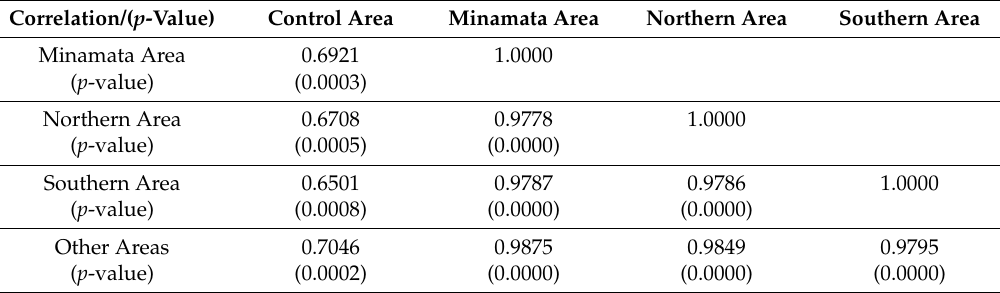
Table 6. Correlation of prevalence of symptoms (Always and Sometimes) among each area.